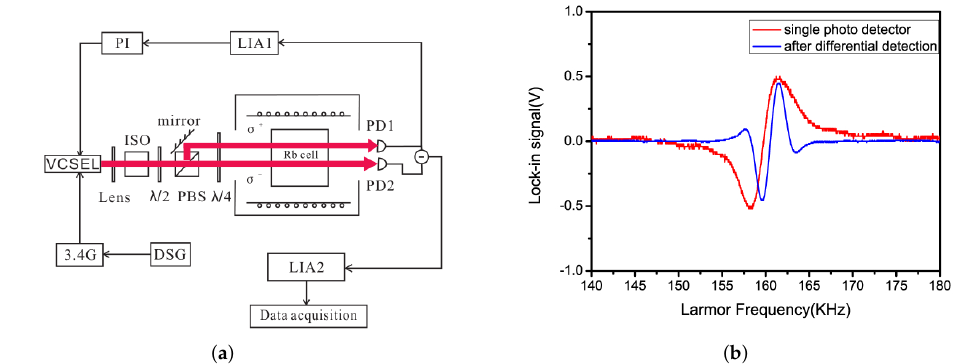
Figure 11. ( a ) The experimental setup for differential detection; ( b ) the lock-in signals after differential detection and of the single photo detector